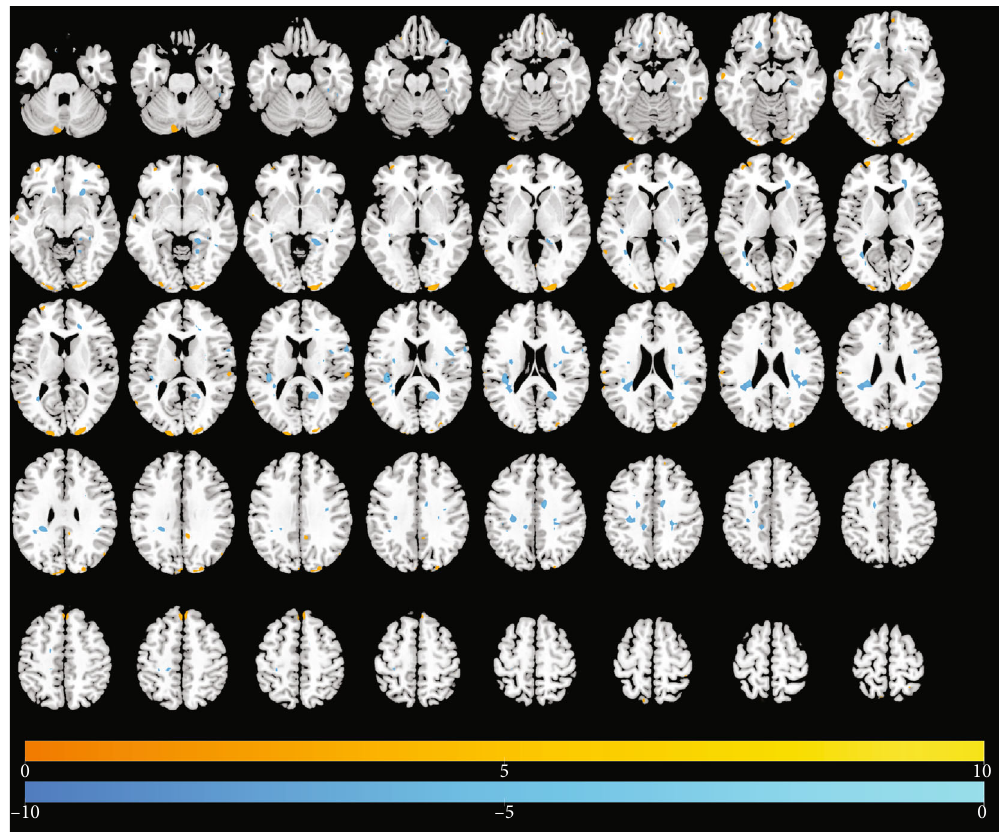
Figure 5: Di ff erences in the magnitude of DC between the same upper-limb amputee patients and control subjects at 6 months of rs-fMRI scan. Same conventions as in Figure